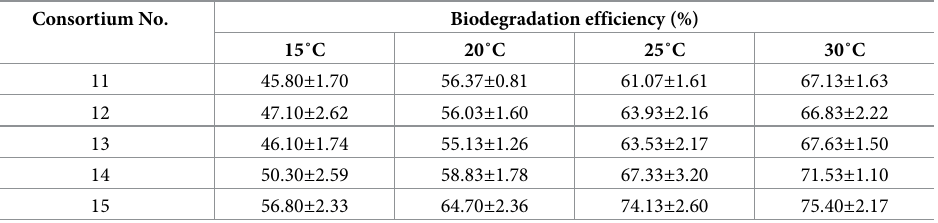
Table 10. Effect of temperature on biodegradation efficiency of crude oil of 5 fungal consortia. Consortium